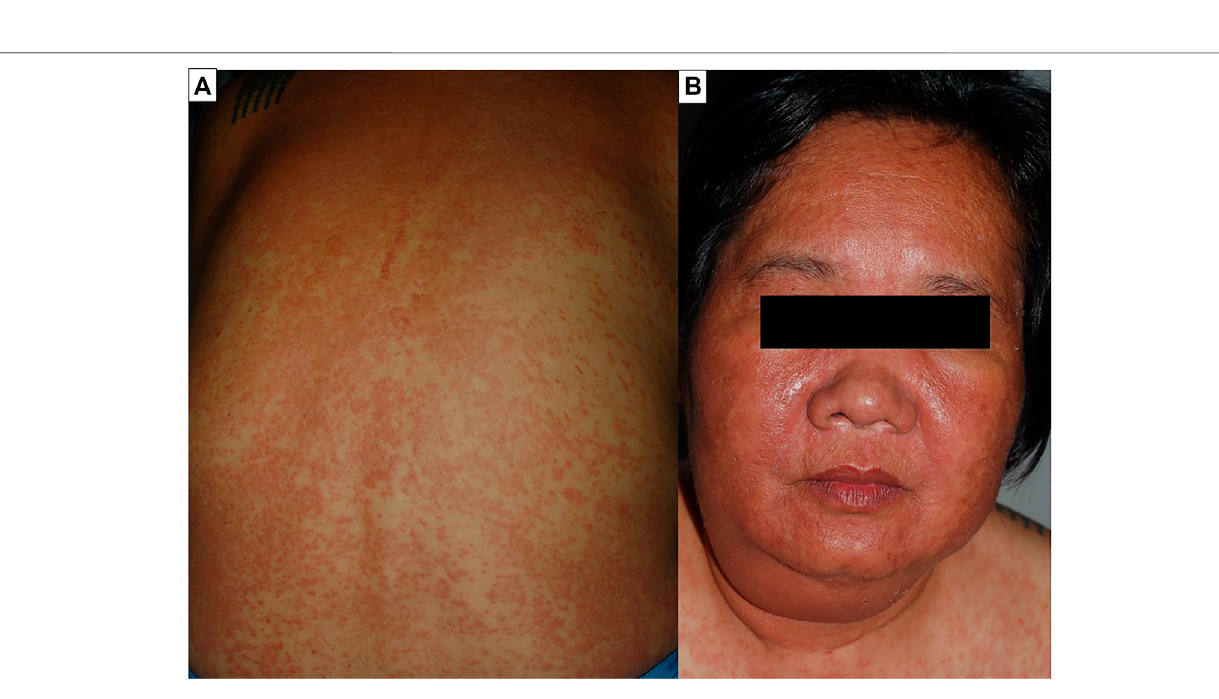
Frontiers in Pharmacology |